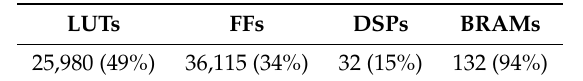
Table 1. BNN implementation utilization report on